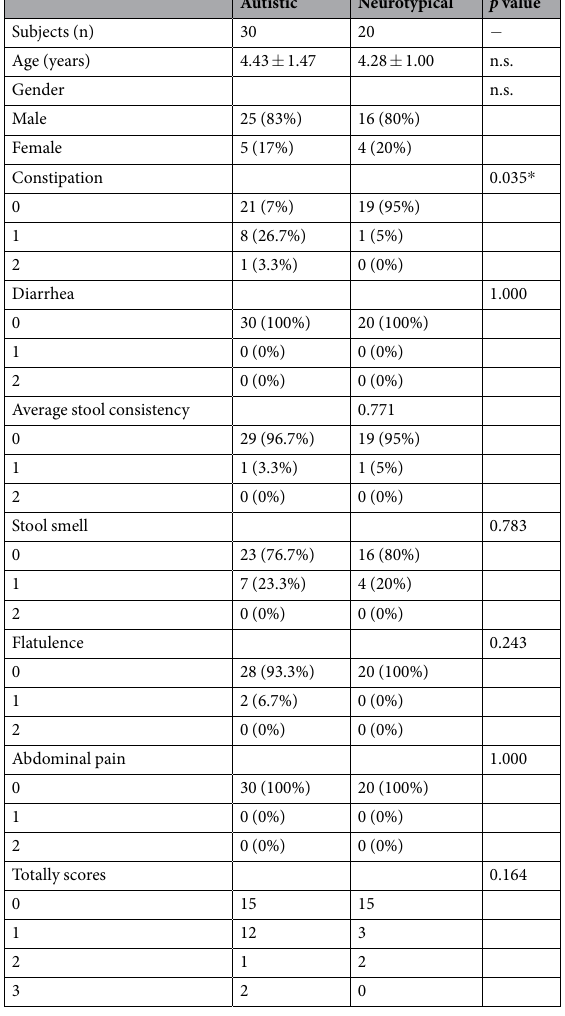
Table 1. Characteristics and GI symptom scores of participants. Note: n.s. means not statically significant. * p < 0.05 vs NT